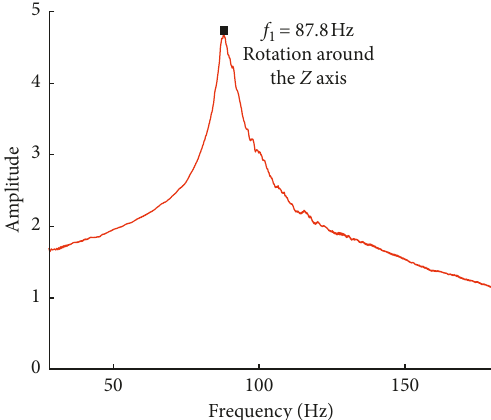
Figure 21: Tested first natural frequency of the